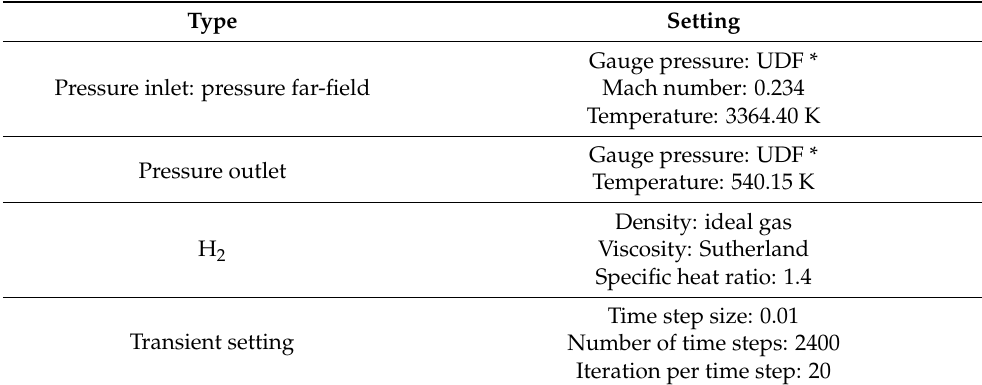
Table 1. The CFD